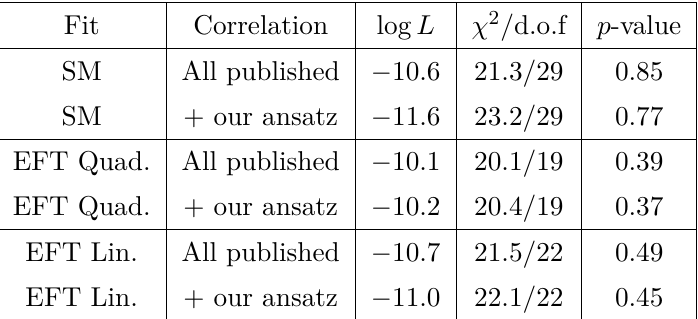
Table 3 . Values of log L, χ 2 / d.o.f and p -values for different assumptions on the correlations among the measurements in the SM and EFT fits. “All published” include the theoretical correlations and the published experimental correlations of the t ¯ tZ , t ¯ tγ , F 0 − F L and LEP/SLD measurements. The number of degrees of freedom (d.o.f.) is the number of observables ( n obs ) minus the number of fitted parameters and minus one. We assume Gaussian errors to extract the χ 2 from log L